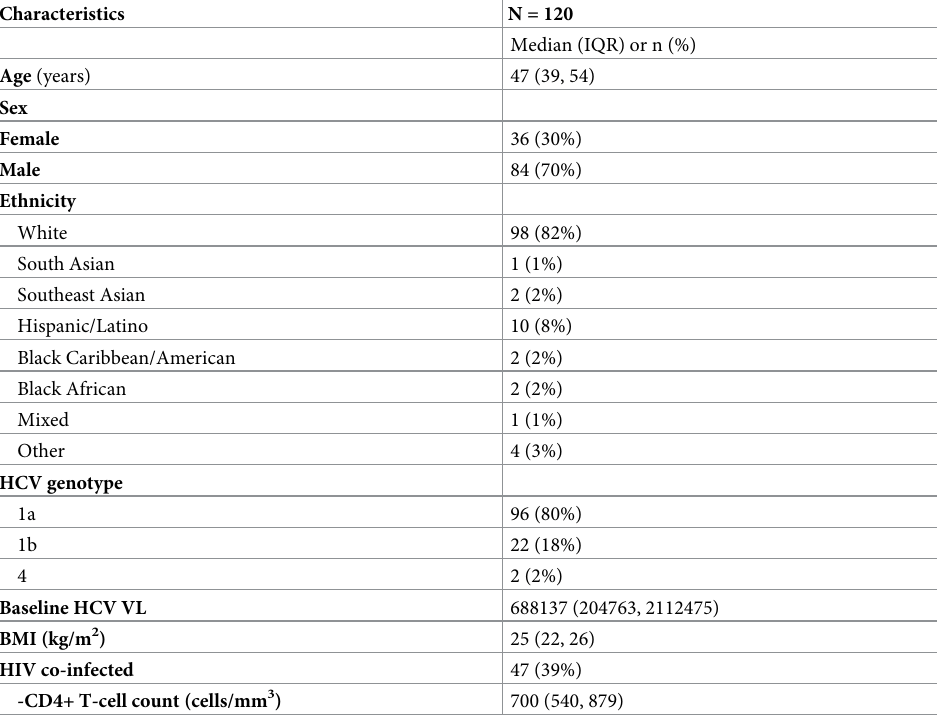
Table 1. Baseline demographic, clinical and viral